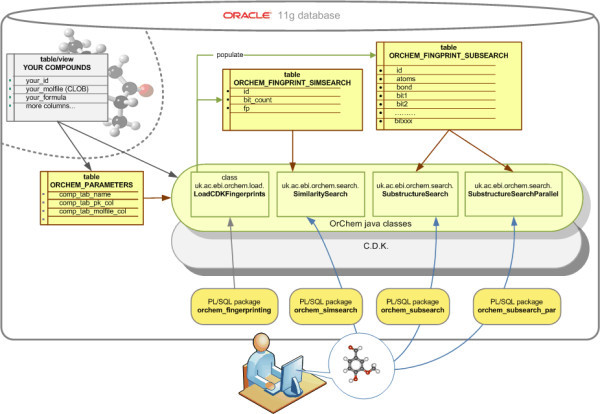
OrChem overview.